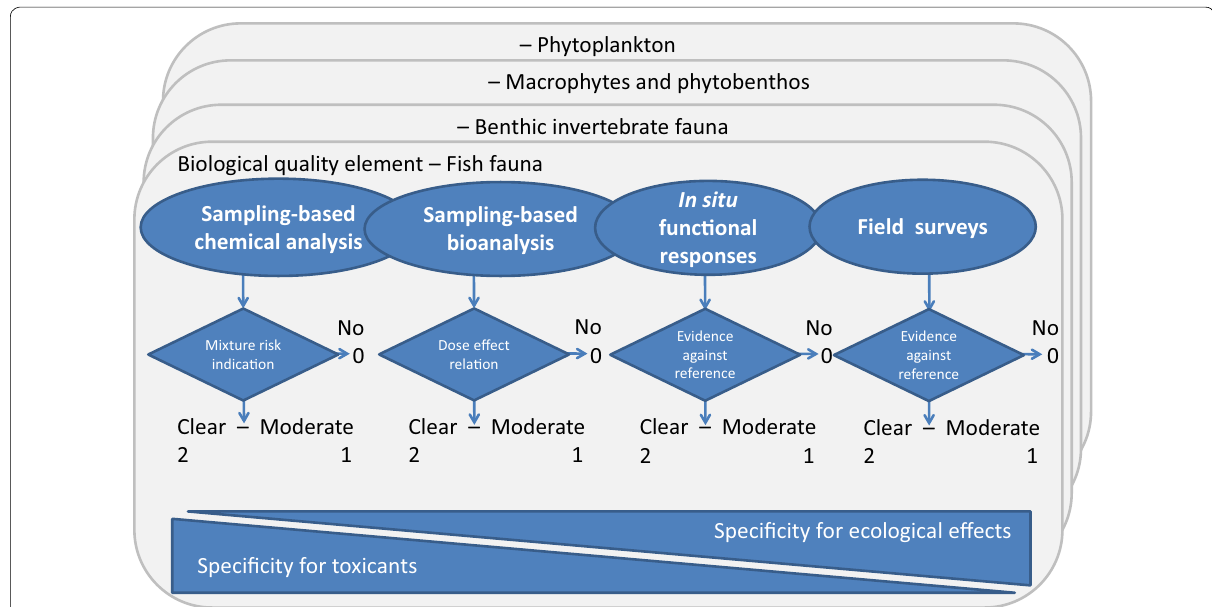
Fig. 7 Aggregating information from different lines of evidence (LOEs) into a weight of evidence matrix specific for each biological quality element to support cause–effect relationships between chemical contamination and ecological effects; Spectrum of outcomes between chemistry (mixture toxicity potential) and ecology (effects at community levels). In situ responses can link between those ends; four main LOEs, including the elements of evidence for which additional information may be included. The in situ LOE includes tests from the sub‑organism to the community level. Mechanistic information for different action by pollutants is conserved by differentiation among the LOEs for the different biological